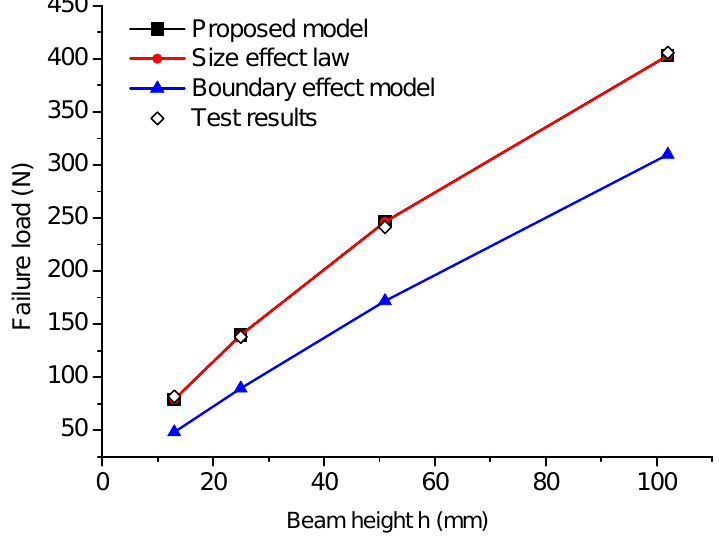
Figure 13. Model predictions of failure load versus beam height comparing with Type 2 SEL predictions, boundary effect model predictions and test results of